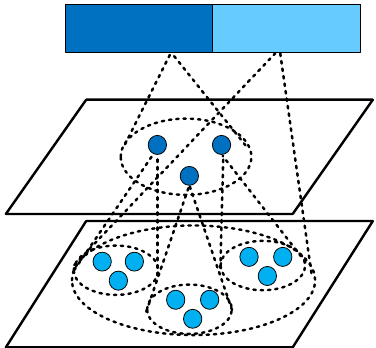
Figure 6. Hierarchical feature extraction schematic.